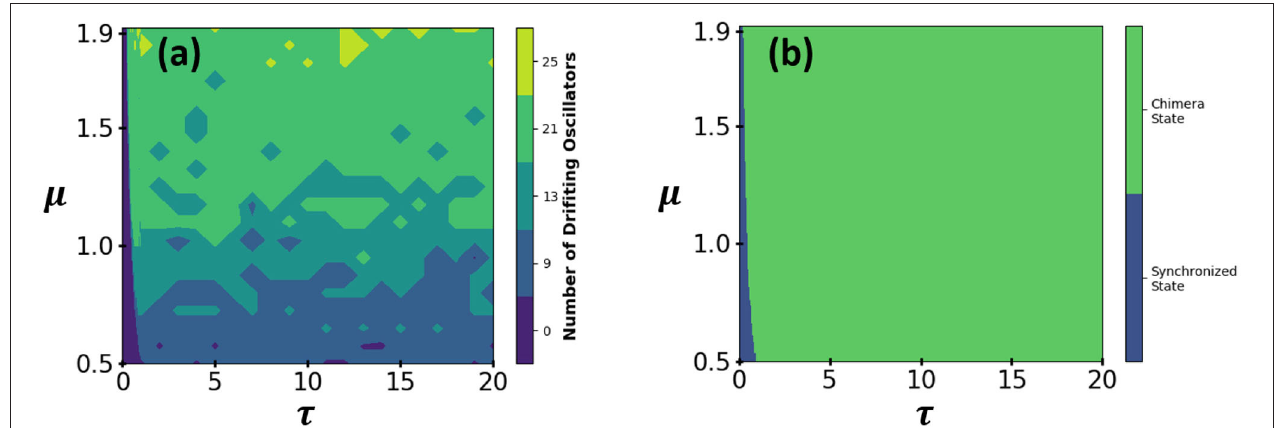
Frontiers in Physics |